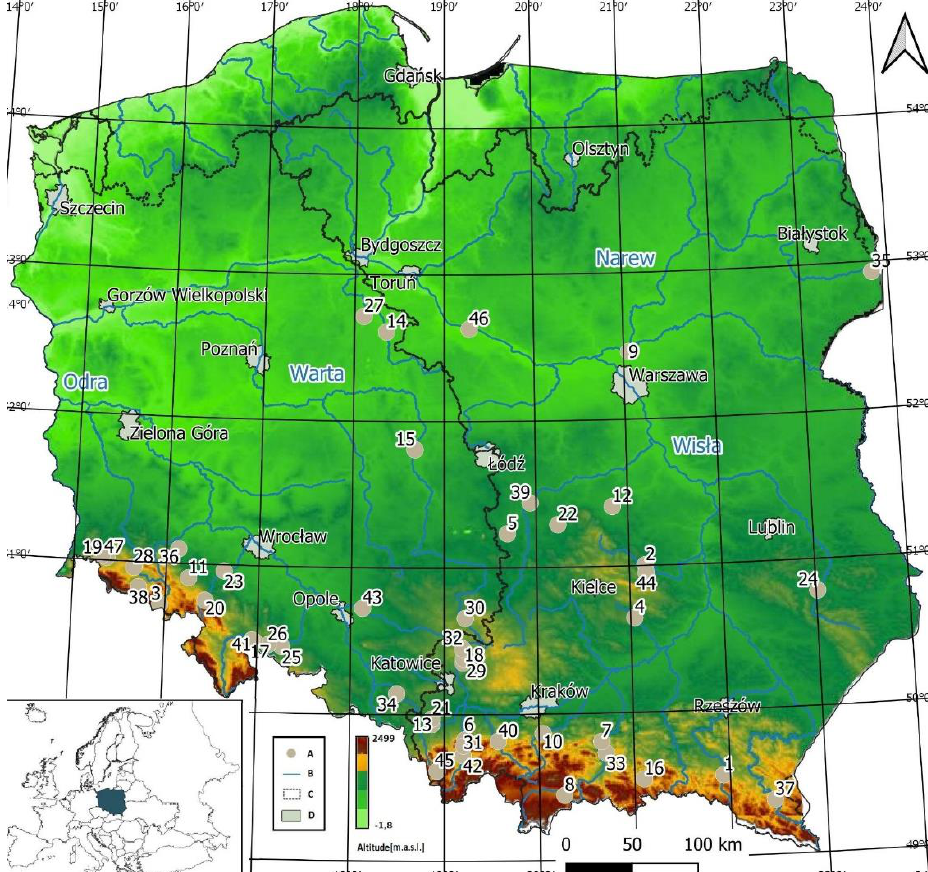
Figure 1. Location of 47 key reservoirs in Poland ( A ) against the map of the river network ( B ) and the main river basins and first-order watersheds ( C ) and main cities ( D ). The basic parameters of the reservoirs listed on the map are given in Table A1. The background of the map is a digital terrain model obtained from the Head Office of Geodesy and Cartography. Reservoirs: 1. Besko, 2.